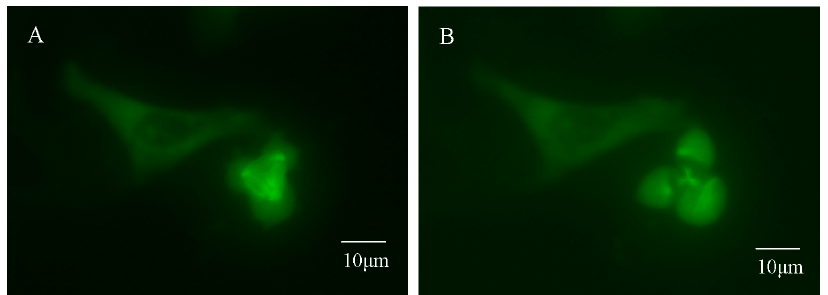
Figure 9. One U-2 OS cell with tripolar spindle divide into three parts. pmEGFP-alpha-tubulin is transfected into U-2 OS cells, and then living cells are observed by Workstation. The microtubules and spindles were found clear in green. Three-spindle cell (A) divides into three parts (B) in 10